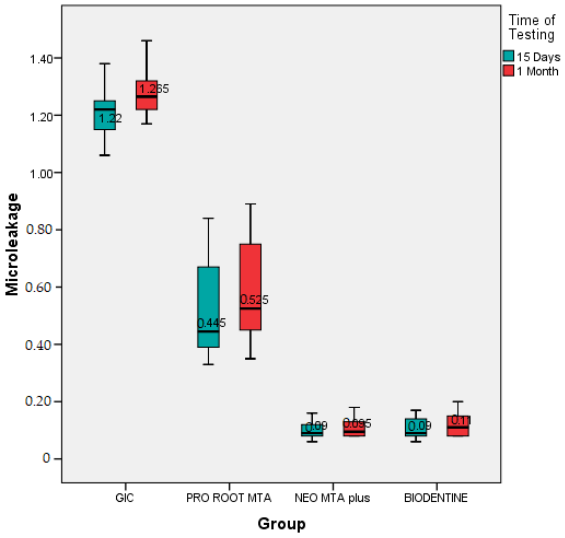
Figure 6. Box-and-whisker plot analysis to compare micro-leakage across the four root end filling materials under consideration.